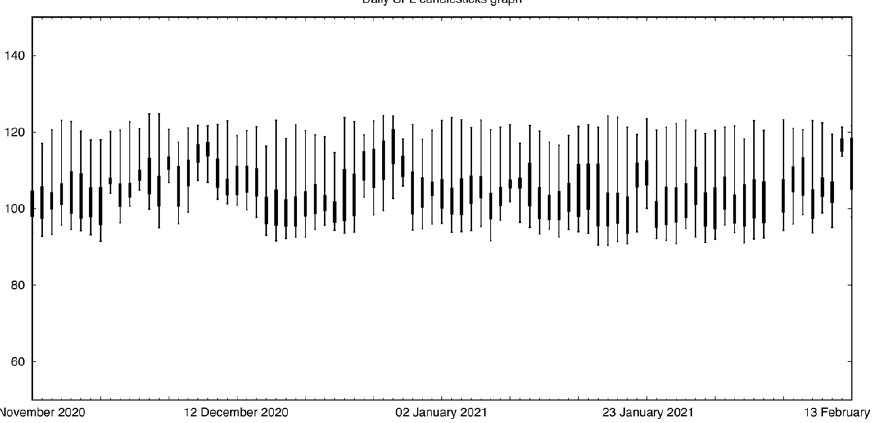
Figure 12. Candlestick graph showing the range of SPL values (whiskers) and the first and third quartile of the time series occurring throughout each day (box). It is possible to see that the distribution of SPL during the day is not symmetrical and bell shaped.